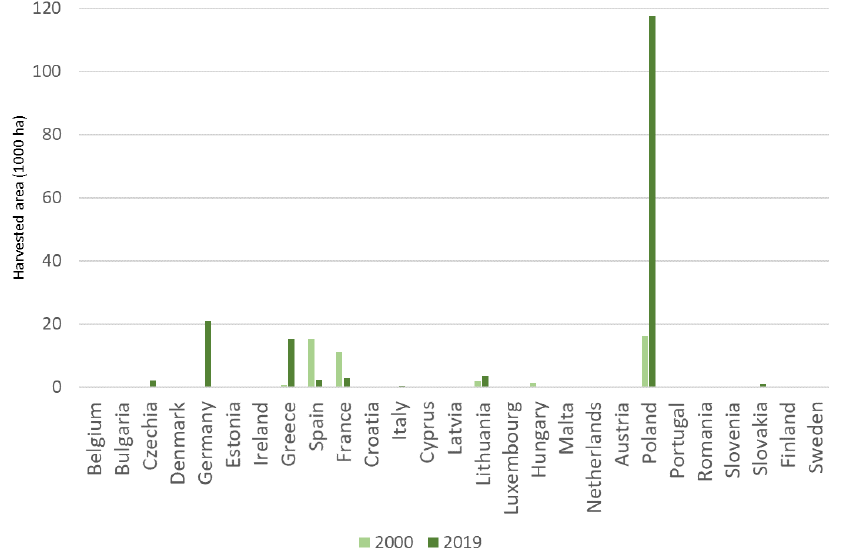
Figure 14. Number of white lupin varieties in EU countries [44]. The effect of the European Protein Plan can be observed by the registration of new white lupin varieties as well. In 2019 and in 2020, more than two new varieties were reg- istered (Figure 15).